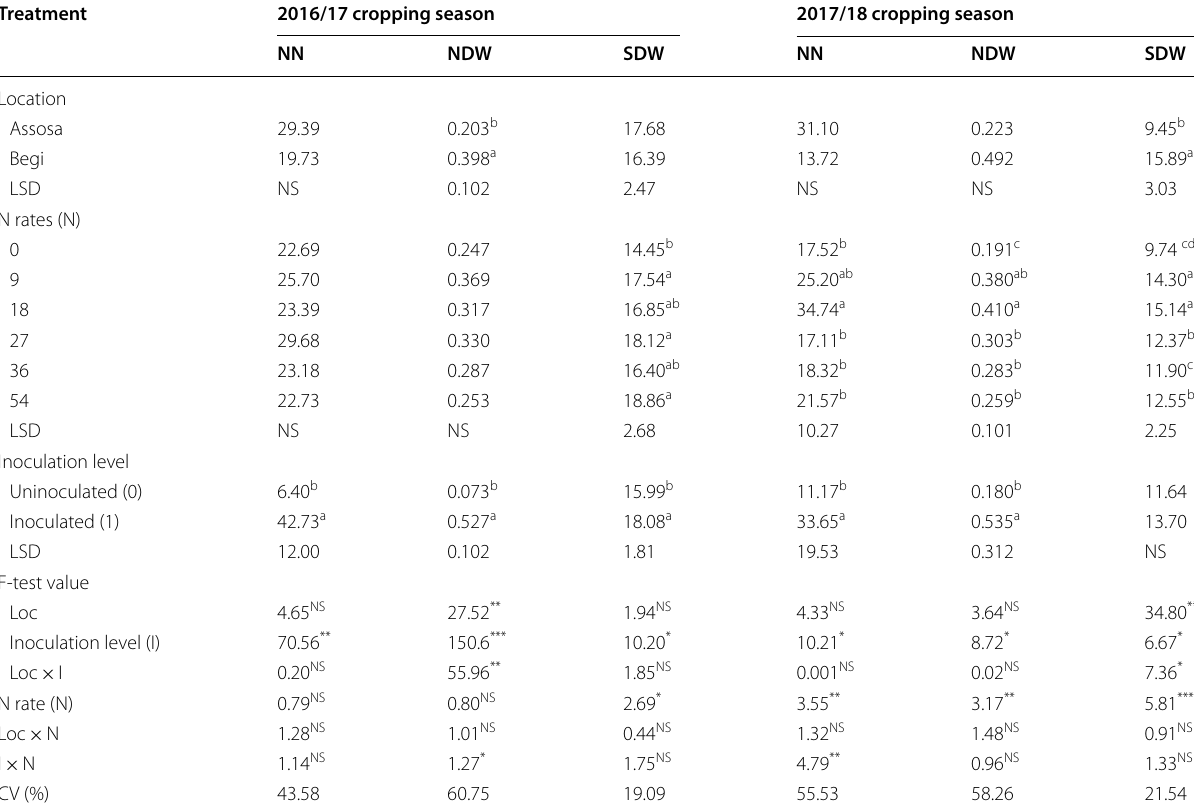
Table 3 Effect of N rates and Rhizobial inoculation on nodulation and shoot dry matter of soybean for 2016/17 and 2017/18 cropping